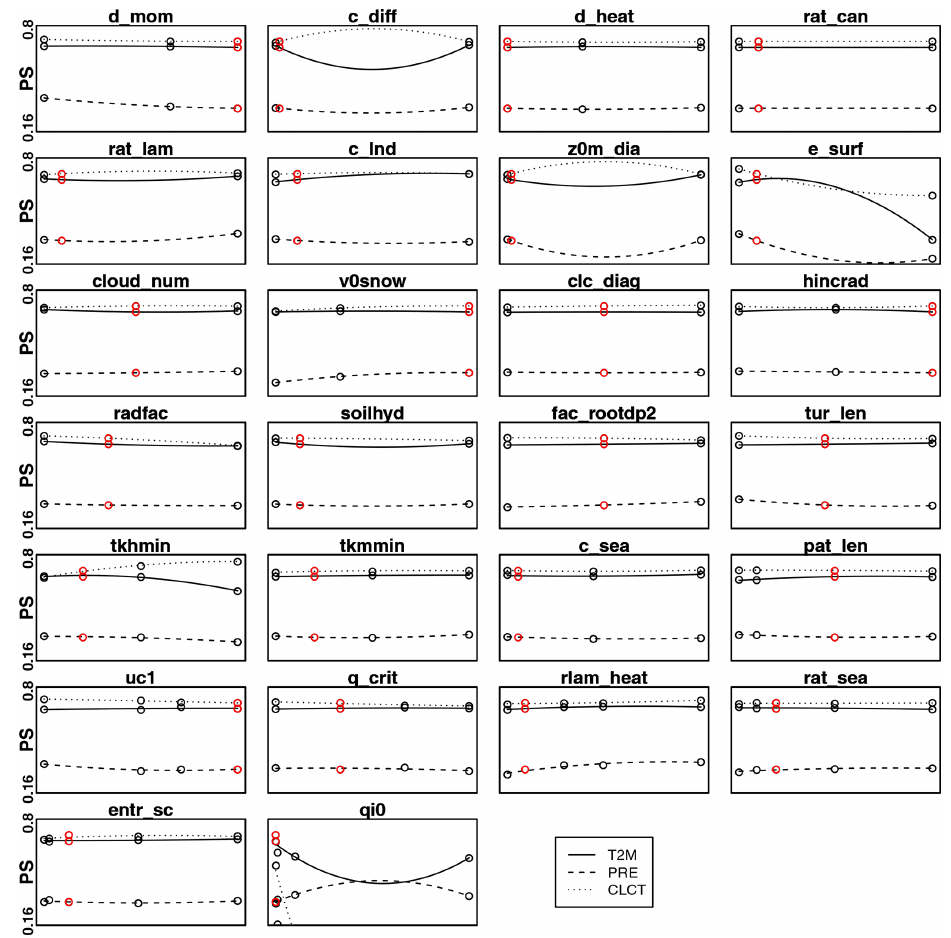
Figure 4. PS calculated separately for near-surface temperature (T2M, solid line), daily precipitation (PRE, dashed line) and total cloud cover (CLCT, dotted line), for all the different tested parameter values, over the entire